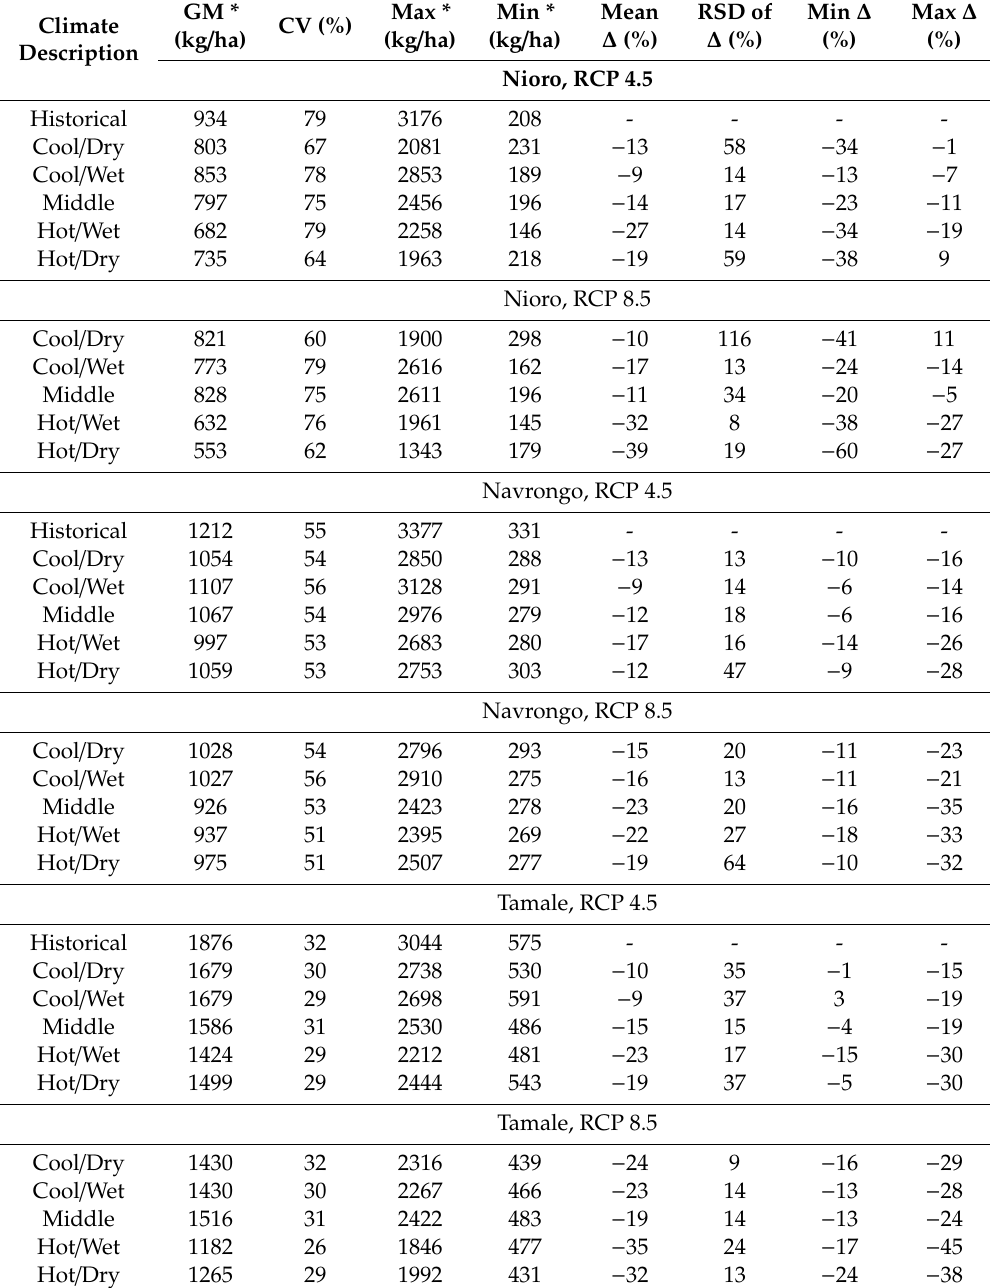
Table 7. Impact of climate change scenarios on maize grain yield (kg / ha) in semi-arid regions in West Africa.